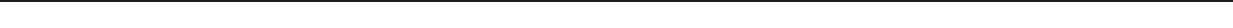
Fig. 2 Nucleoporin depletion disrupted Kcnq1ot1 ncRNA volume and Kcnq1ot1 domain positioning at the nuclear periphery. a Representative confocal nuclear images displaying Kcnq1ot1 DNA (magenta) Kcnq1ot1 ncRNA (cyan) and DAPI staining (blue) for G1-synchronized control and Nup -depleted XEN cells ( n = 4; cell number = 109 – 123); upper panel, DNA FISH; middle panel, RNA FISH; lower panel, merge; M maternal domain, P paternal domain; white dashed line denotes nuclear rim. In these images, red and green fl uorescence was converted to magenta and cyan. b , c Percent of cells with paternal or maternal Kcnq1ot1 ncRNA signals. d Percent of cells with Kcnq1ot1 ncRNA signal volume; low, 0 – 0.7 μ m 3 ; medium, 0.7 – 1.4 μ m 3 ; high, 1.4 – 2.1 μ m 3 ; very high, >2.1 μ m 3 . e Distance of the paternal and maternal Kcnq1ot1 domain from the nuclear membrane in control and Nup -depleted XEN cells. The maternal Kcnq1ot1 domain was randomly positioned within the nucleus (expected nuclear periphery (NP) 15%; subnuclear periphery (SP) 30%; nuclear interior (NI) 60%), except for Nup153 -depleted cells with a Kcnq1ot1 ncRNA signal (si153 M + ). For these analyses, cells with no RNA but detectable DNA FISH signals were included, while those lacking DNA signals were excluded. NP, 0 – 0.5 μ m; SP, 0.5 – 1.5 μ m; NI, 1.5 – 4 μ m; error bars, s.e.m.; *, signi fi cance p < 0.05 compared to vehicle control ( t test); WT wild type, Veh vehicle, siNT nontargeting siRNA, si107 Nup107 siRNA, si62 Nup62 siRNA, si98/96 Nup98/96 siRNA, si153